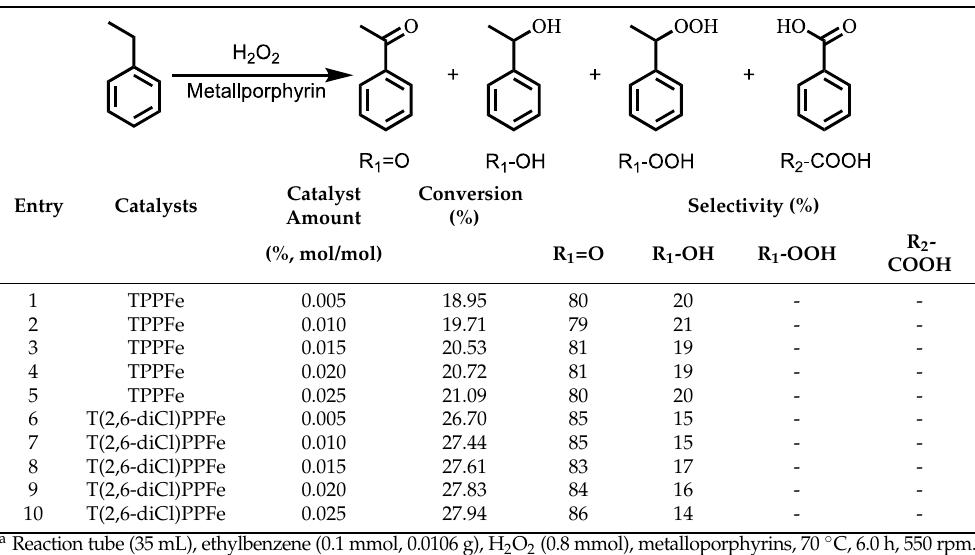
Table 4. Effect of catalyst amount on alkyl aromatics oxygenation employing ethylbenzene as model substrate a .